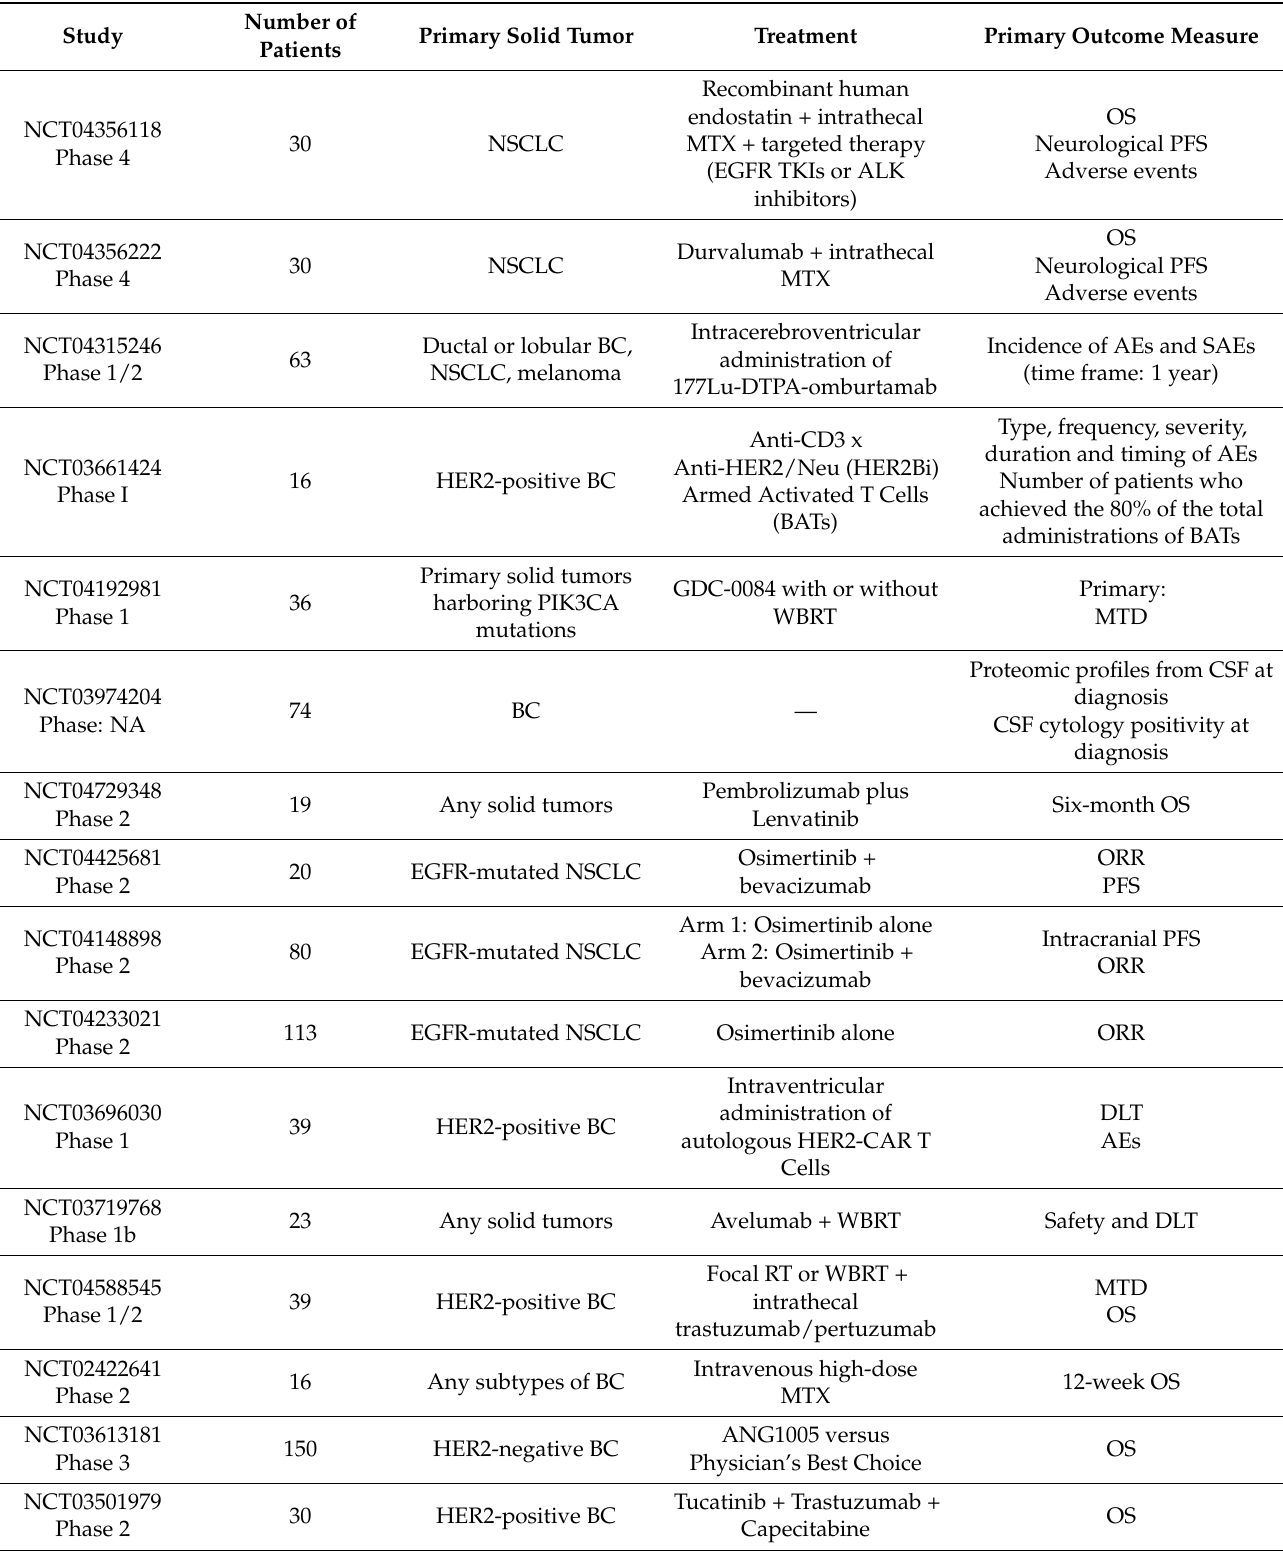
Table 5. Ongoing clinical trial on LM (from https://clinicaltrials.gov, last update 1 March